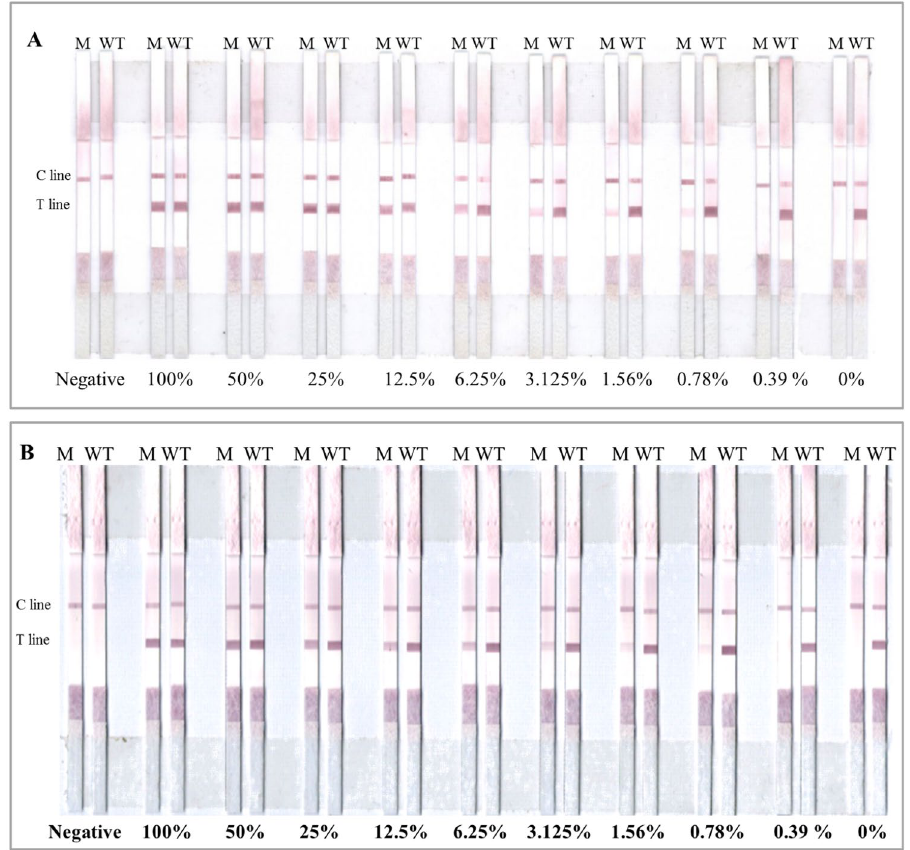
Figure 2. Sensitivity testing of the PCR-GoldMag LFA by serial dilution experiment. Serial dilution of the heterozygous mutant cell line DNA NCI-H-1650 and NCI-H-1975, with control wild-type DNA from cell lines NCI-A549, respectively. Mixtures with the following proportions of DNA from mutant cells were prepared: 100%, 50%, 25%, 12.5%, 6.25%, 3.125%, 1.56%, 0.78%, and 0% (no mutant DNA). ( A ) E746-A750 deletion. ( B ) The L858R